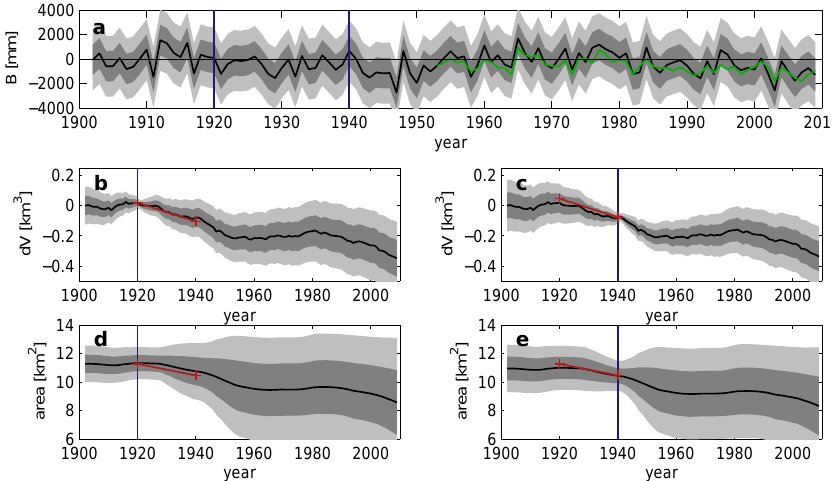
Fig. 13. Validation of modeled, temporally integrated changes of volume and surface area, and of the propagated model error, using Hin- tereisferner as an example; (a) observed (green) and modeled (black) mass balances; (b) modeled, accumulated (black) and geodetically observed (red) volume change, model in forecast mode; (c) modeled, accumulated (black) and geodetically observed (red) volume change, model in hindcast mode; (d) modeled (black) and geodetically observed (red) surface area, model in forecast mode; (e) modeled (black) and geodetically observed (red) surface area, model in hindcast mode; dark (light) shading indicates 1 (2) standard errors; vertical lines indicate years of surface area